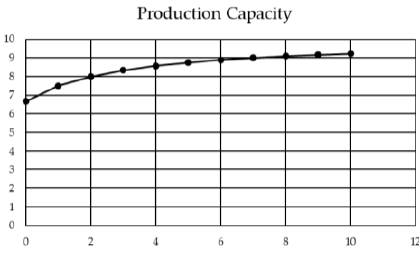
Figure 9. Three-parameter hyperbolic learning curve model [20].